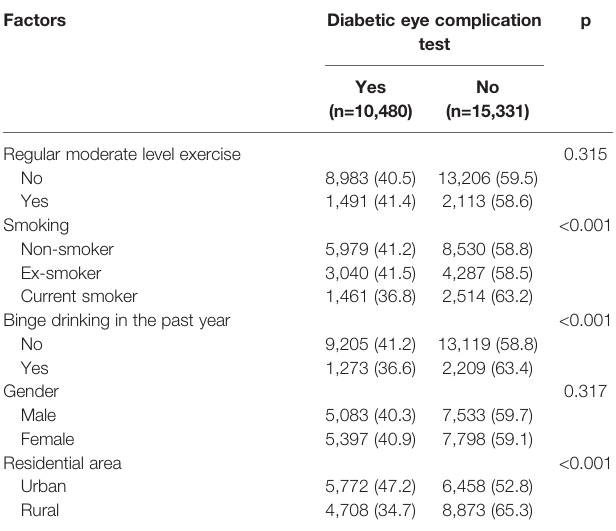
TABLE 2 | Characteristics of subjects according to the diabetic kidney complication test (microprotein urination test), n